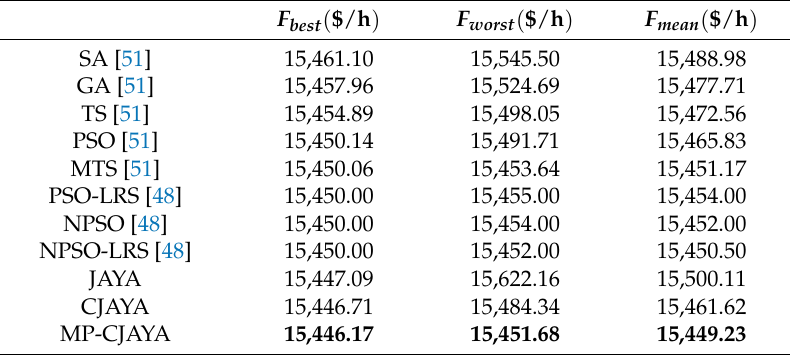
Table 6. Results comparison of 6-units system ( P D = 1263